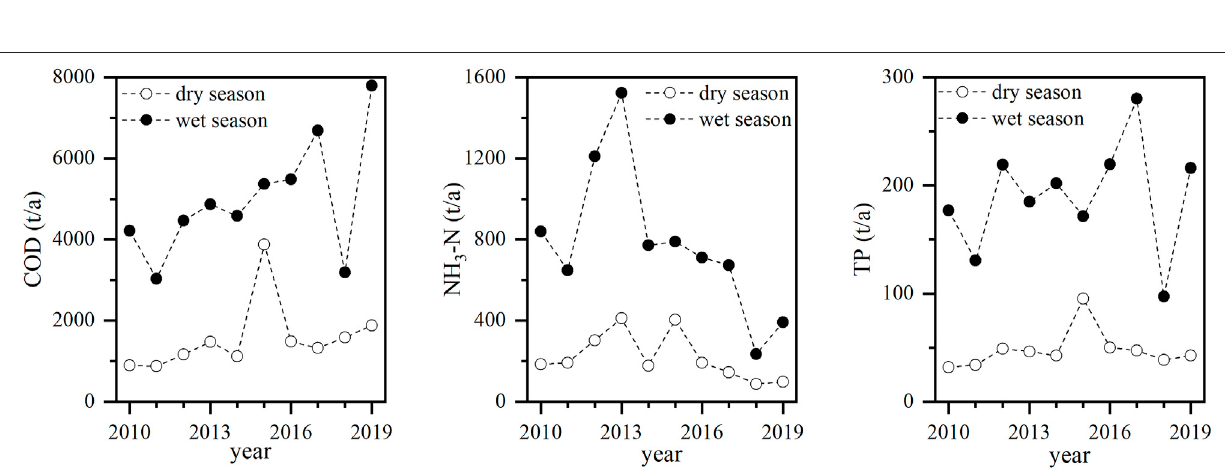
Frontiers in Environmental Science |